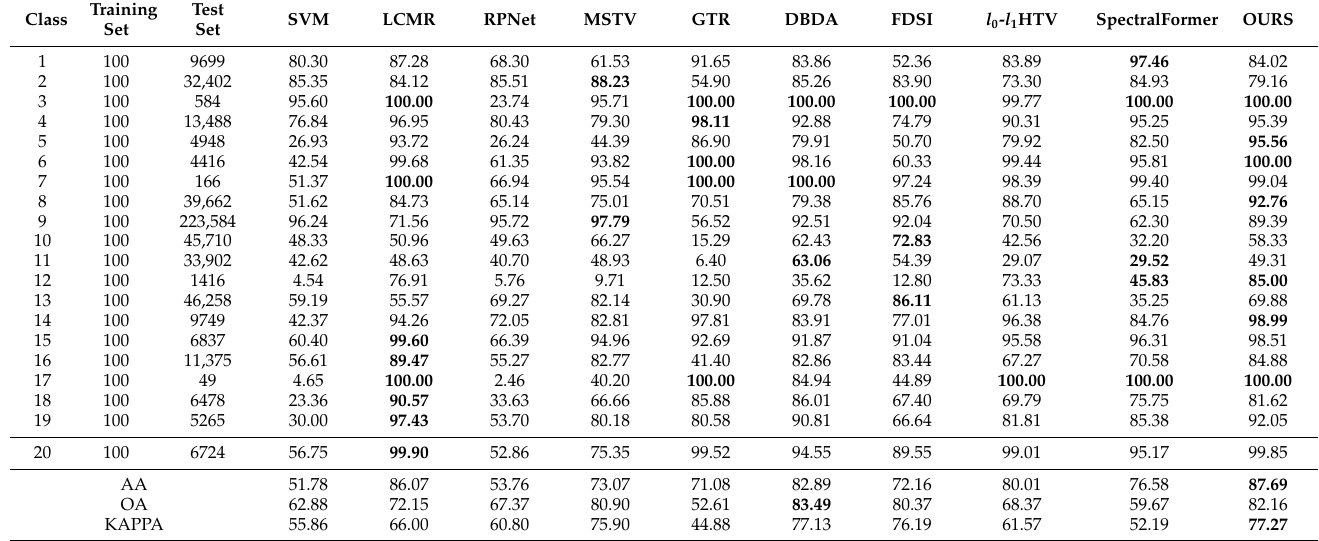
Table 6. Experimental results (percentage) on Houston University 2018 dataset obtained by different methods. The best results are highlighted in